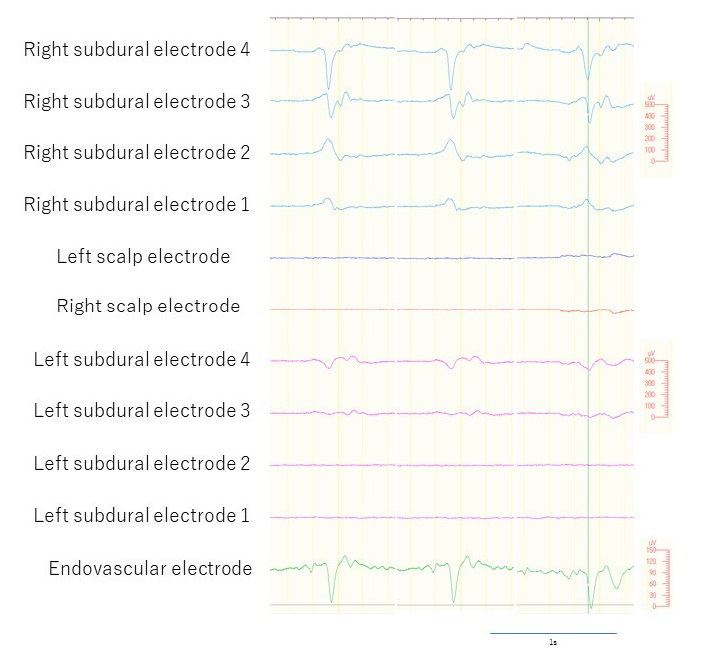
Figure 4. Selected epileptiform discharges. Epileptiform discharges detected by right subdural electrodes (sky blue lines), but undetected by left subdural electrodes (pink lines). The endovascular electrodes detected epileptiform discharges (green line).